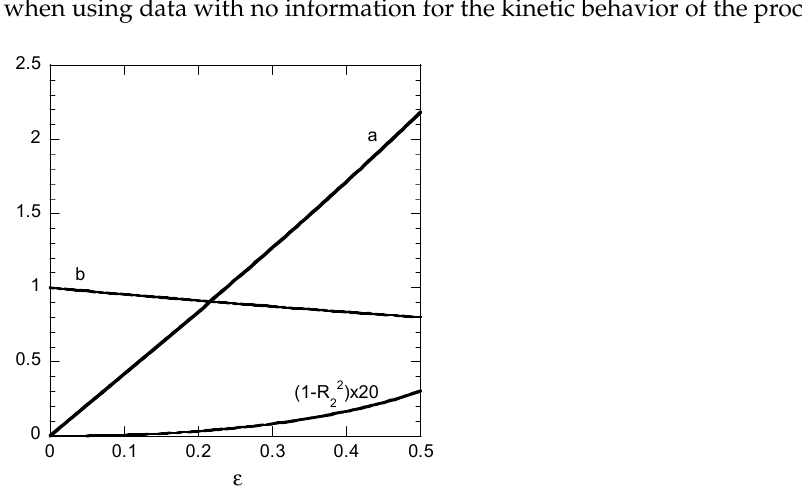
Figure 3. Example 2: Pseudo-second order linear fit extracted parameters and corresponding correla- tion coefficient R 22 versus noise amplitude parameter ε .